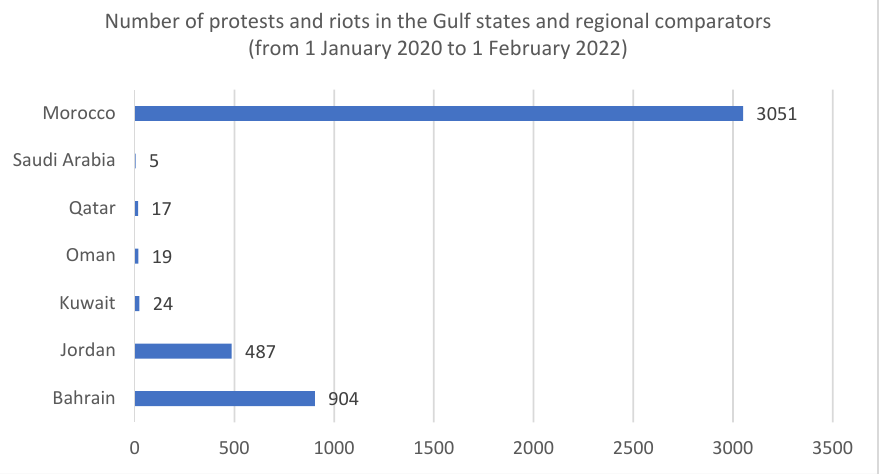
Figure 2. Protests and riots in the Middle East during COVID-19. Source: Armed Conflict Location and Event Data Project [3]. Note: No data was available for the UAE.